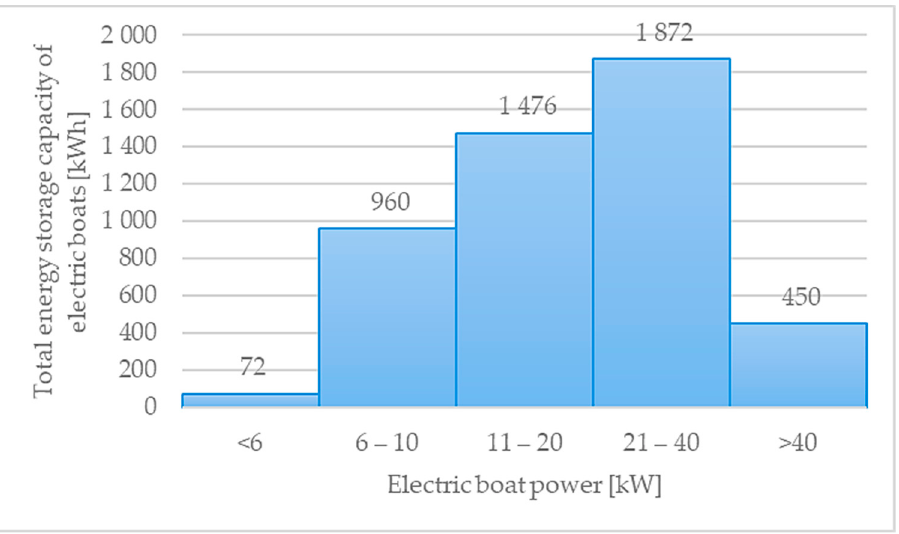
Figure 8. The distribution of the total energy storage capacity of the small electric boats in the sailing marinas of Lake Balaton in 2021 by the power of their electric motors, own results.